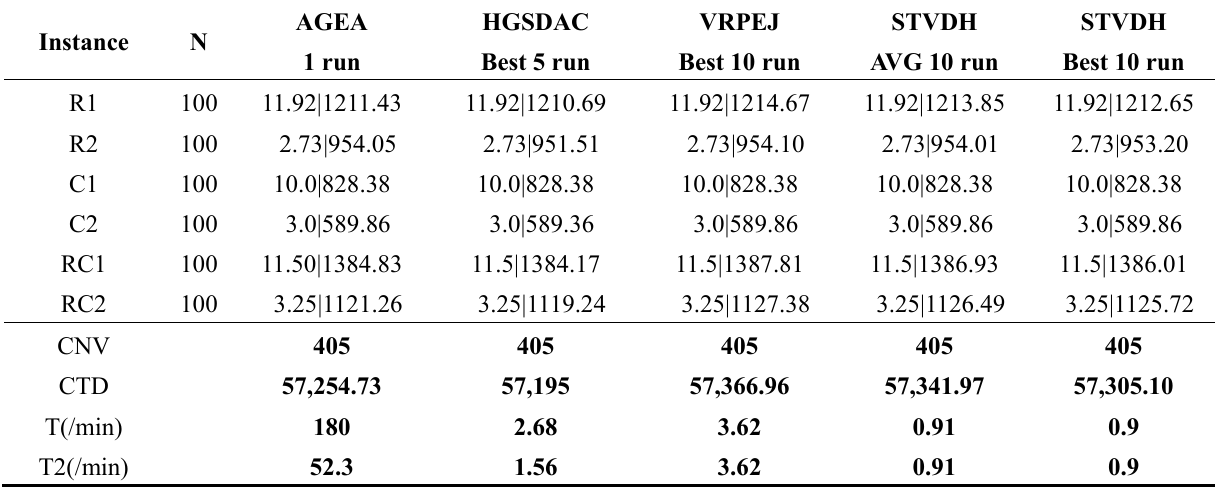
Table 2. Comparison of results on the Solomon VRPTW benchmarks